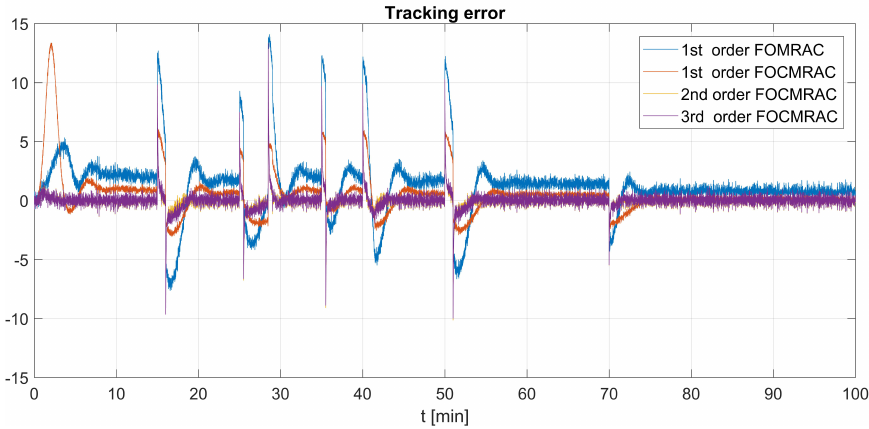
Figure 18. Tracking error of the adaptive schemes under disturbances and noisy